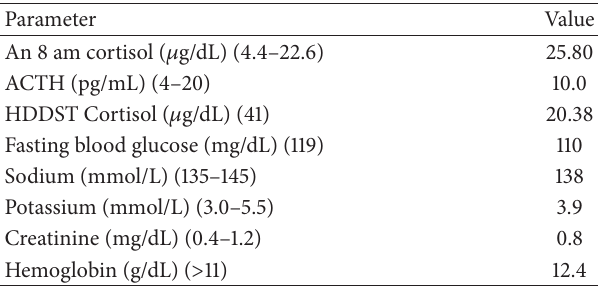
Table 1: Biochemical evaluation of the